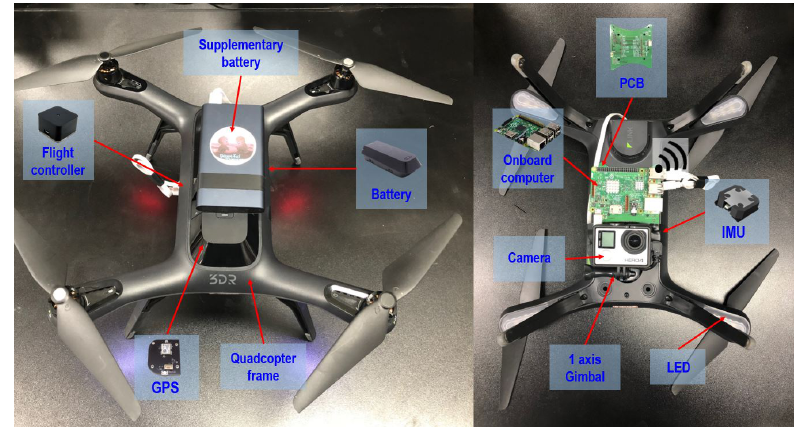
Figure 3. Quadcopter type unmanned aerial vehicle: 3DR SOLO. We attached additional hardware to the 3DR SOLO and performed a remote sensing task. The left picture is from the top view and the right is the bottom view of the 3DR